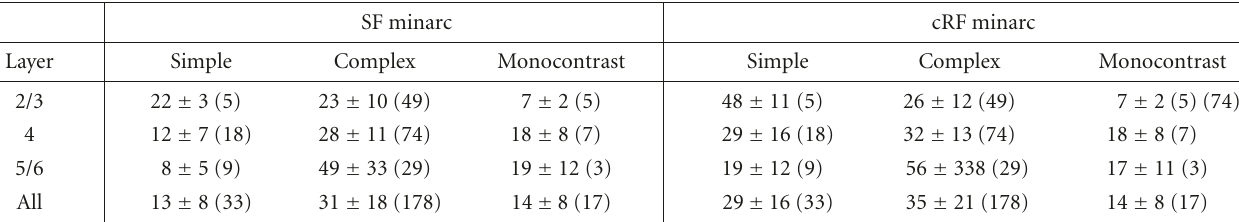
Table 1: Dimensions of summation fields and classical receptive fields in macaque V1. The number of cells is in parentheses. ± values are standard deviations. Monocontrast cells respond either to light or dark bars but not both. This table was obtained from [74]. Note that 1 ◦ = 60 minutes of arc (minarc).